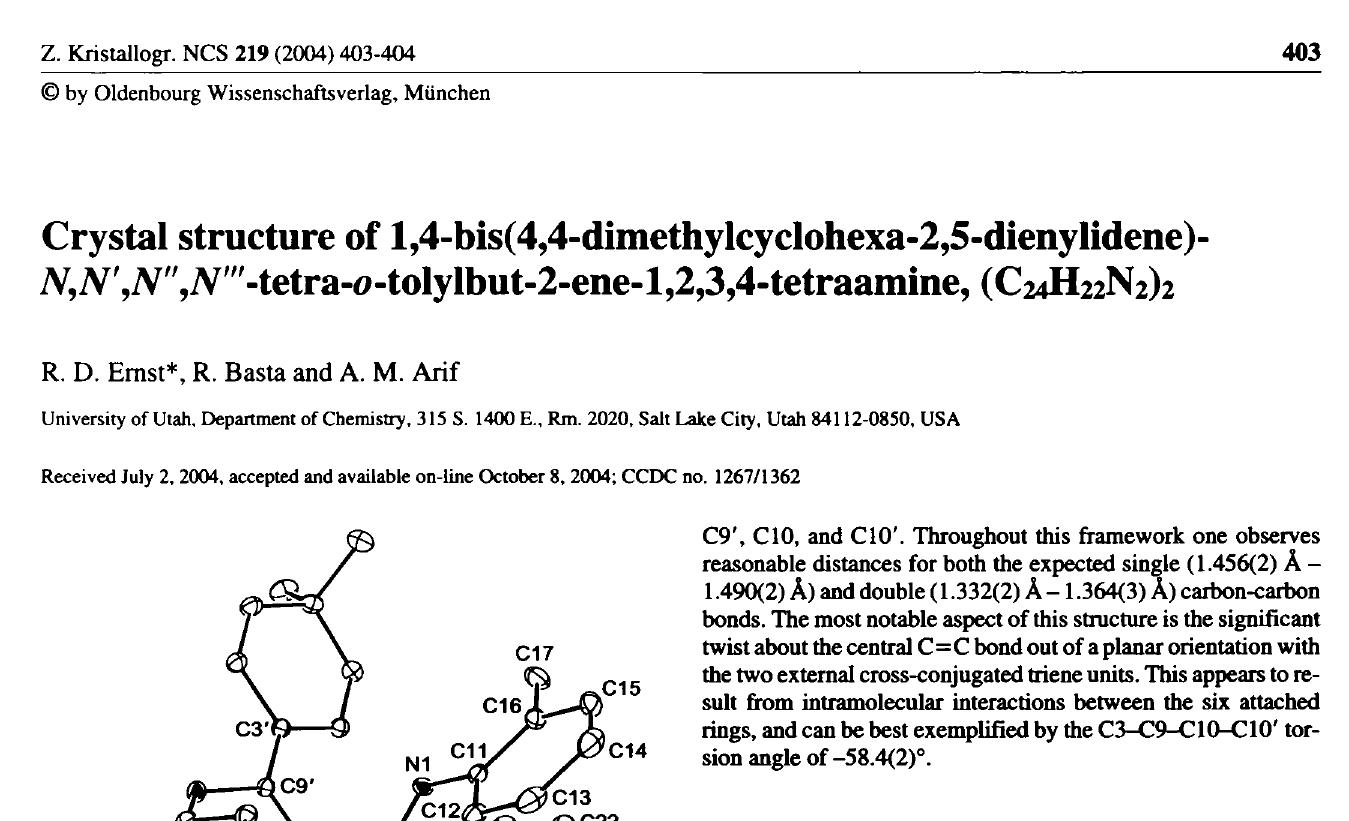
Table 1. Data collection and handling.